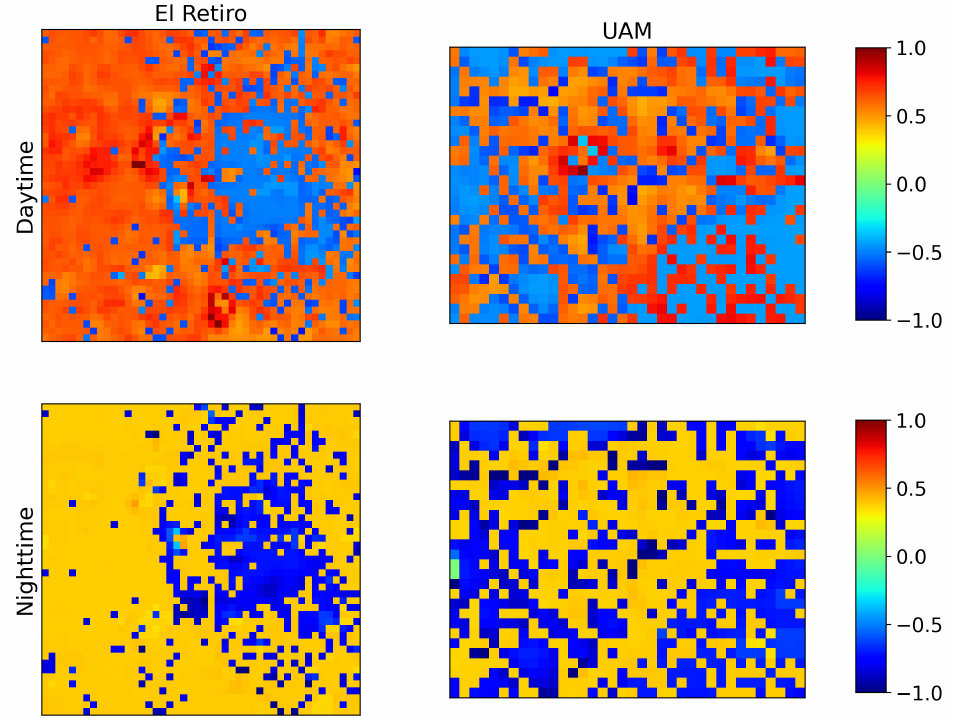
Figure 17. Pixel per pixel difference of the LST in K between the 2MMD-4-band TES and the 1MMD- 4-band TES over the Retiro Park ( left ) and the UAM ( right ) during the daytime ( top ) and nighttime ( bottom